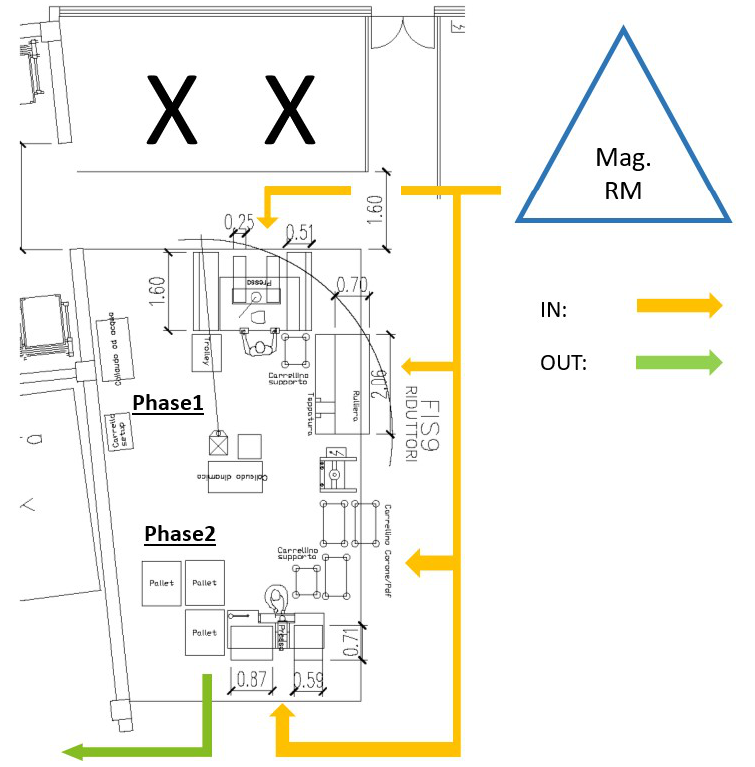
Figure 9. Updated layout with expected feeding